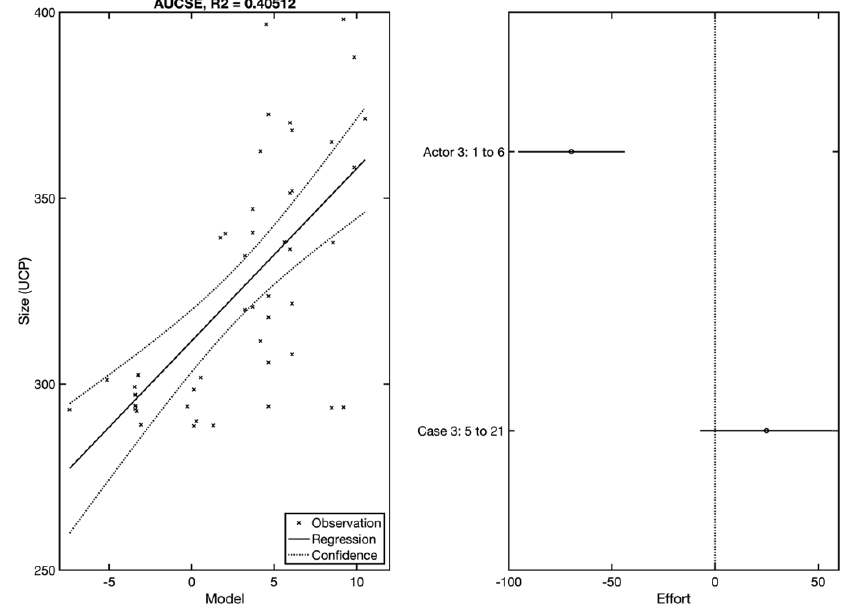
Figure 13. The estimation model and its benefit when utilizing use case model components.